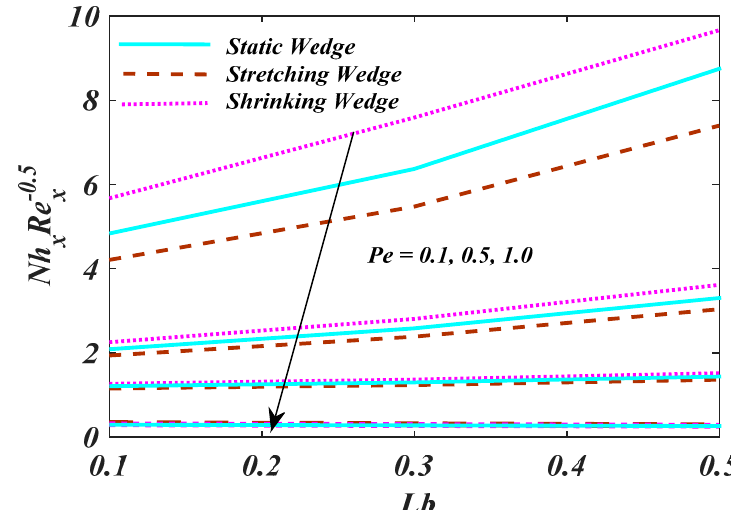
− 1/2 x Nn with variations in Pe and Lb . Figure 15. Plot of (cid:1844)(cid:1857) (cid:3051)(cid:2879)(cid:2869)/(cid:2870) (cid:1840)(cid:1866) with variations in (cid:1842)(cid:1857) (cid:1853)(cid:1866)(cid:1856) (cid:1838)(cid:1854) . Figure 15. Plot of Re